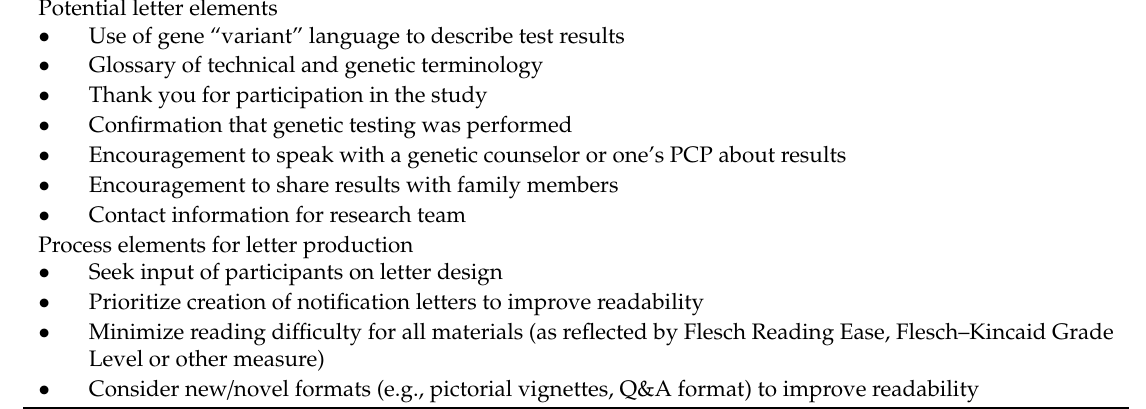
Table 5. Potential letter component and writing process standards from the Electronic Medical Records and Genomics (eMERGE)